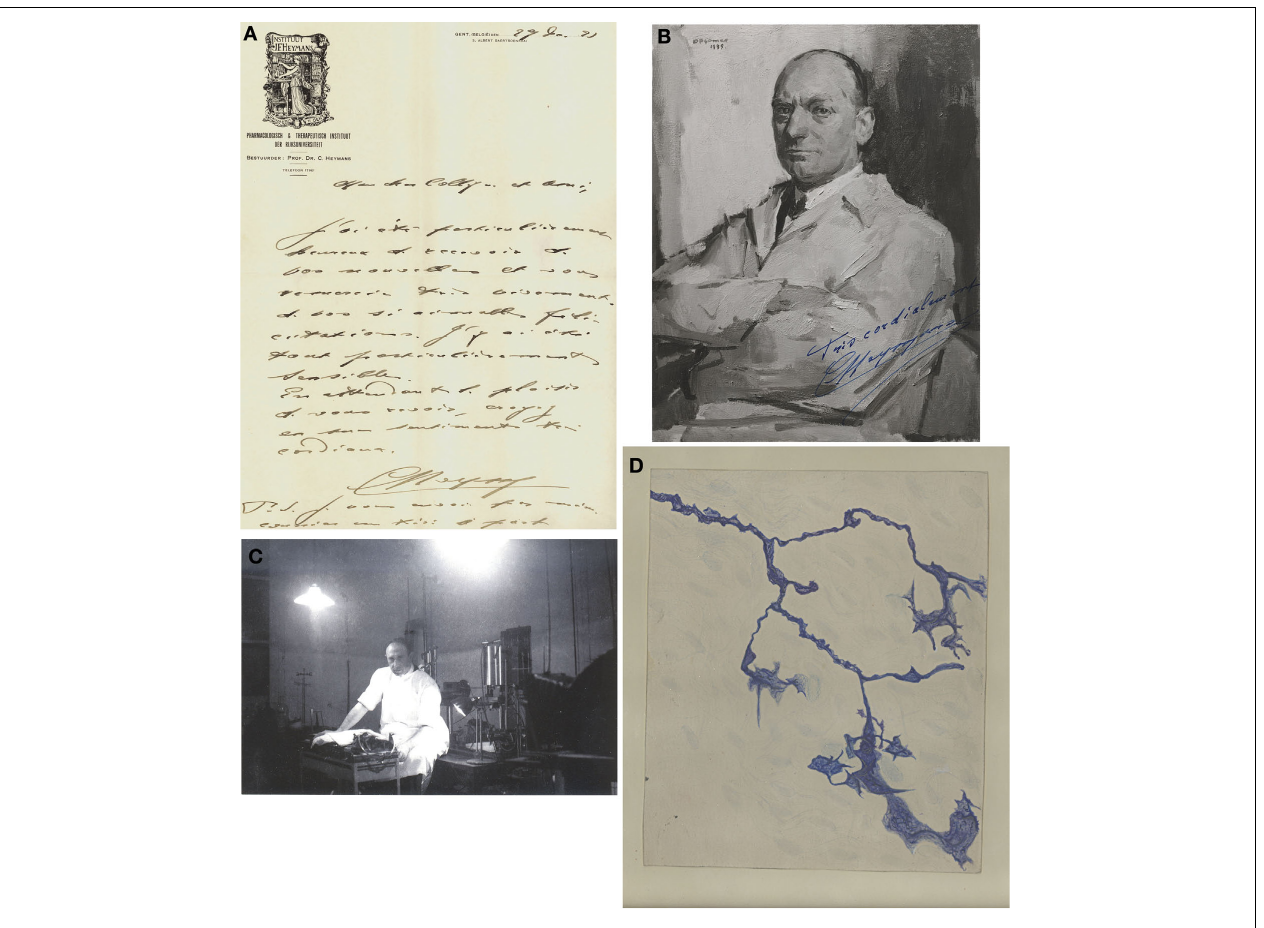
FIGURE 5 | The long friendship of Corneille Heymans and Fernando De Castro. (A) Letter from Heymans, dated 29th December 1939, in response to a previous letter from Fernando De Castro (dated 15th December 1939) where he congratulated the Belgian physio-pharmacologist for the award of the